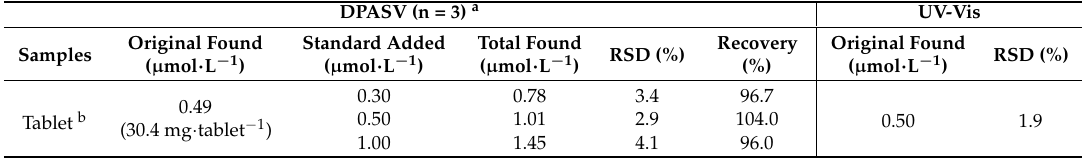
Table 2. Determination of results of urapidil in tablet samples by differential pulse adsorptive stripping voltammetry